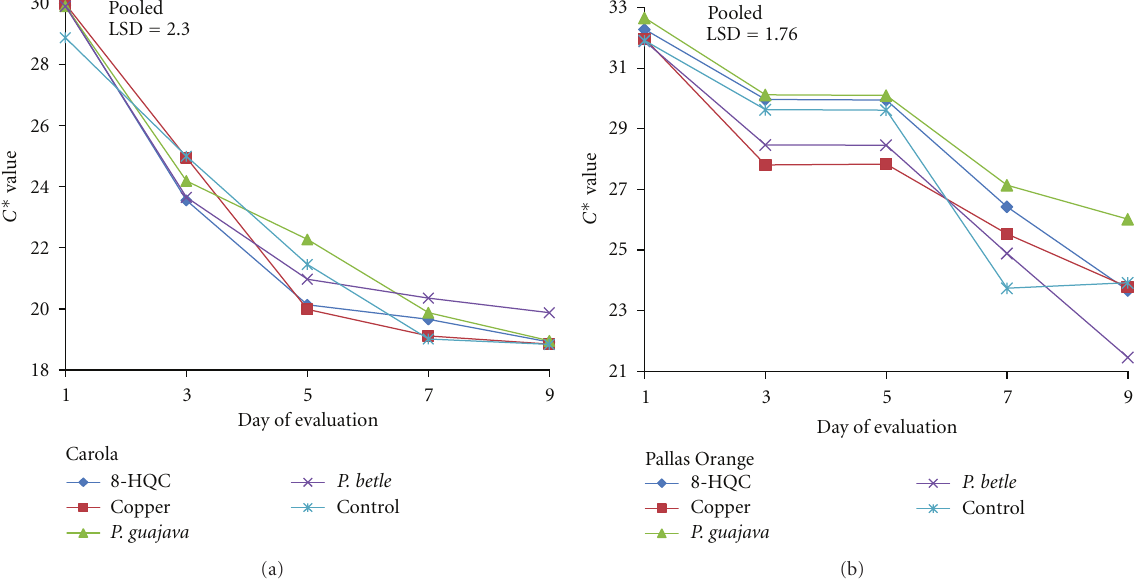
Figure 4: E ff ect of 8-HQC, copper coin, and leaf extracts of P. guajava and P. betle and control on C ∗ value of (a) “Carola” and (b) “Pallas Orange” cut carnation